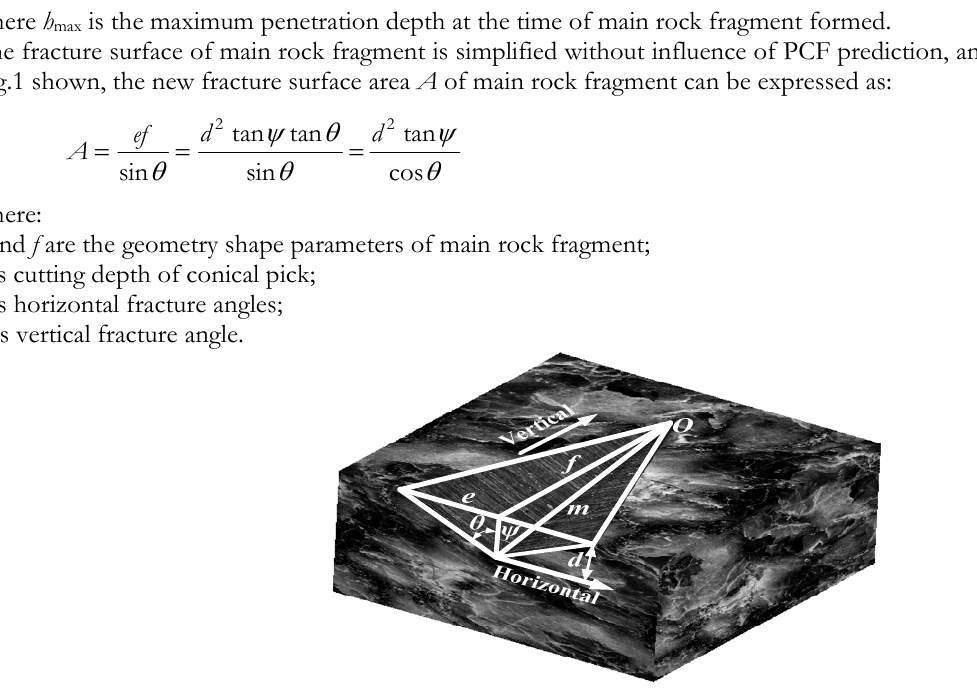
Figure 1: Schematic diagram of fracture surface of rock